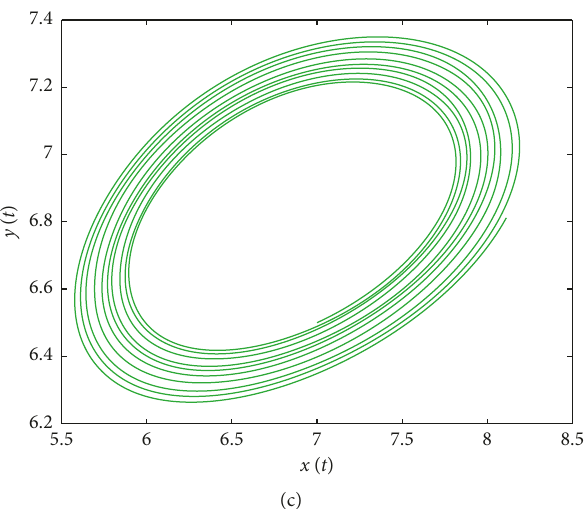
Figure 5: The time series and portrait phase of model (71) when u < Kr /4; here u � 2 ,K � 8 , r � 2, and α � 0 . 29. (a) The time series of x ( t ) ; (b) the time series of y ( t ) ; (c) the portrait phase.